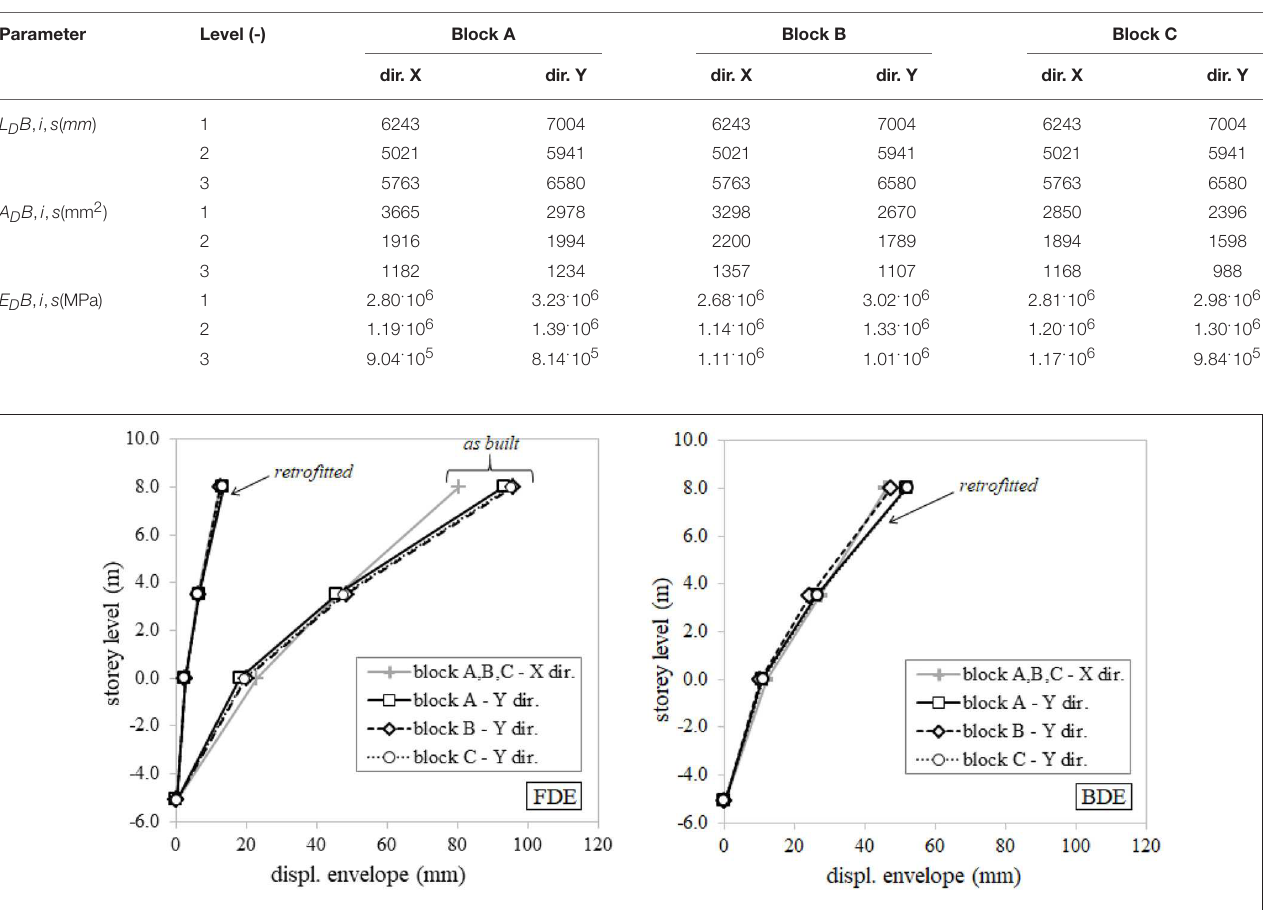
FIGURE 6 | Average displacement envelopes of the three blocks for FDE (left) and BDE (right)